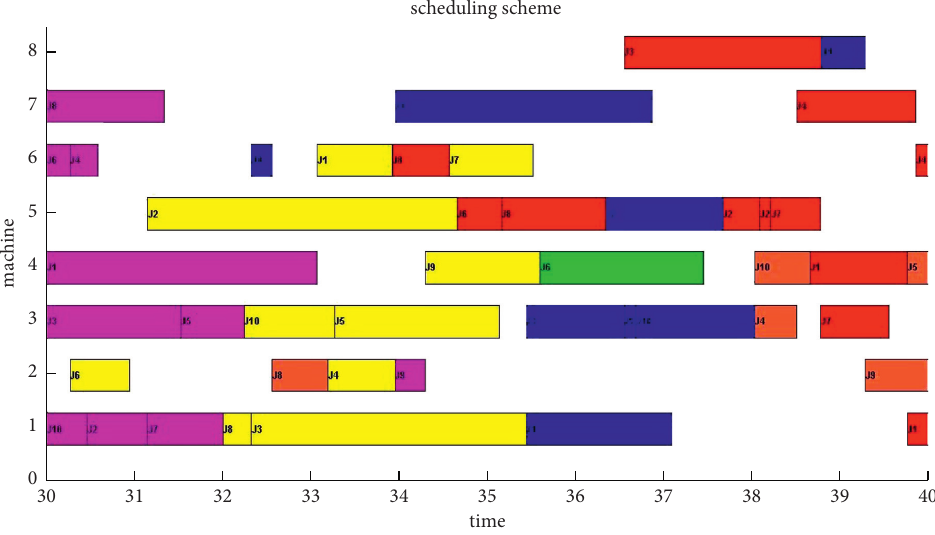
Figure 11: Gantt chart of t � 30 ∼ t � 40 scheduling scheme. Table 5: Tasks to be processed at t �